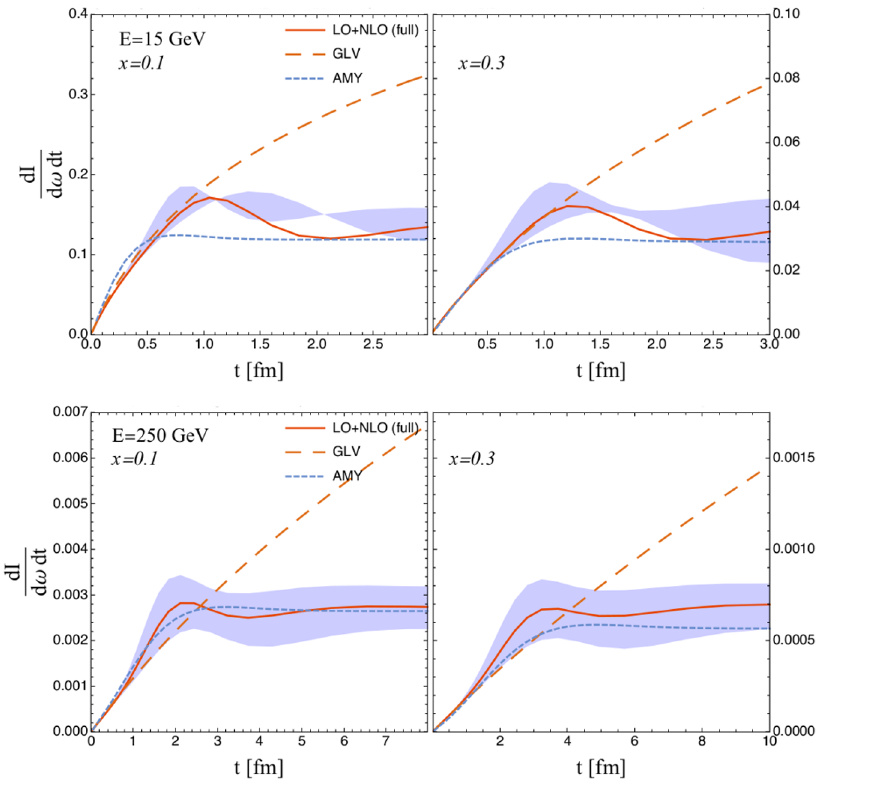
Figure 4 . The rate of medium-induced emissions for a jet with energy E = 15 GeV (upper panel) and E = 250 GeV (lower panel). Medium parameters are ^ q = 1 : 63 GeV 2 /fm and (cid:22) = 0 : 9 GeV, corresponding to g = 1 : 94 and T = 0 : 4 GeV. The dashed (blue) lines labelled \AMY" correspond to the numerical evaluation presented in